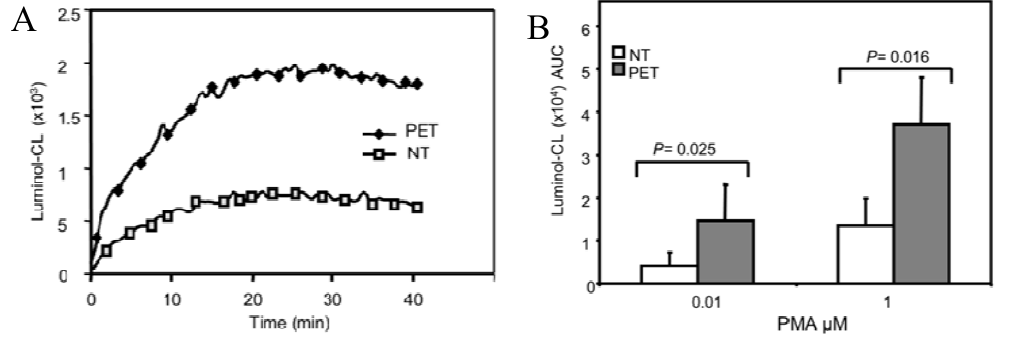
Figure 1. Pre-eclamptic B-lymphoblast cell lines (B-LCLs) display enhanced reactive oxygen species (ROS) production in response to phorbol-12-myristate-13-acetate (PMA). ( A ) Whole cell ROS production was measured from B-LCLs stimulated with 0.01 μ mol/L or 1 μ mol/L PMA added at time = 0 min and measured by luminol-CL (shown as a representative chemiluminescent (CL) recording). ( B ) The area under the curve (AUC)